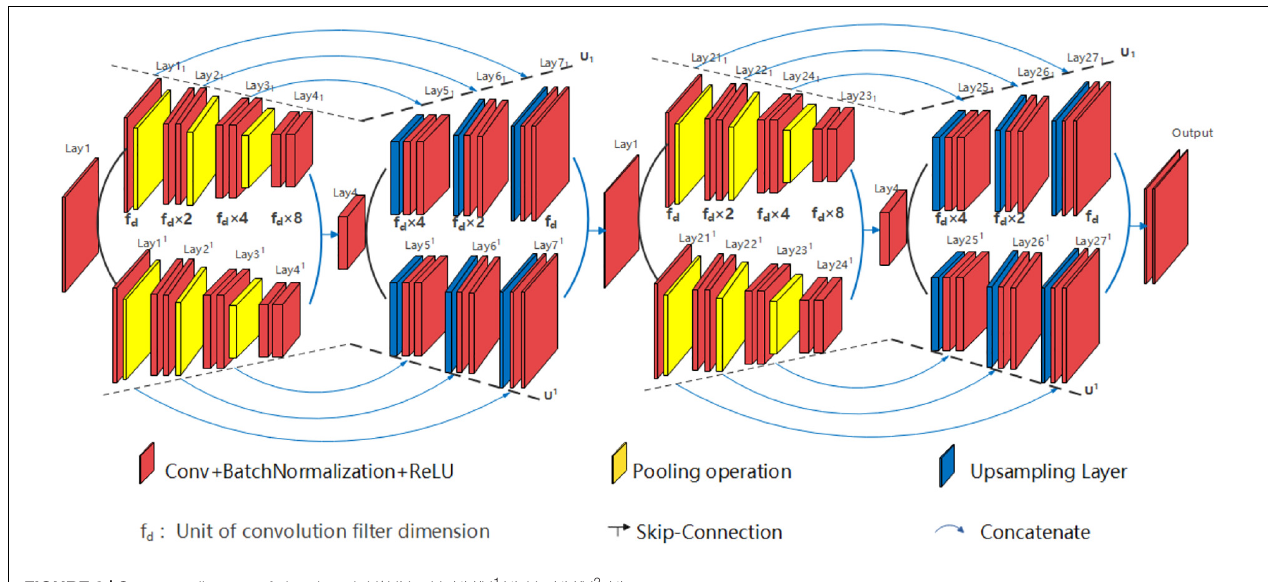
FIGURE 9 | Structure diagram of signal peak U ∗ UNet U 1 (4)//U 1 (4)-U 2 (4)//U 2 (4).